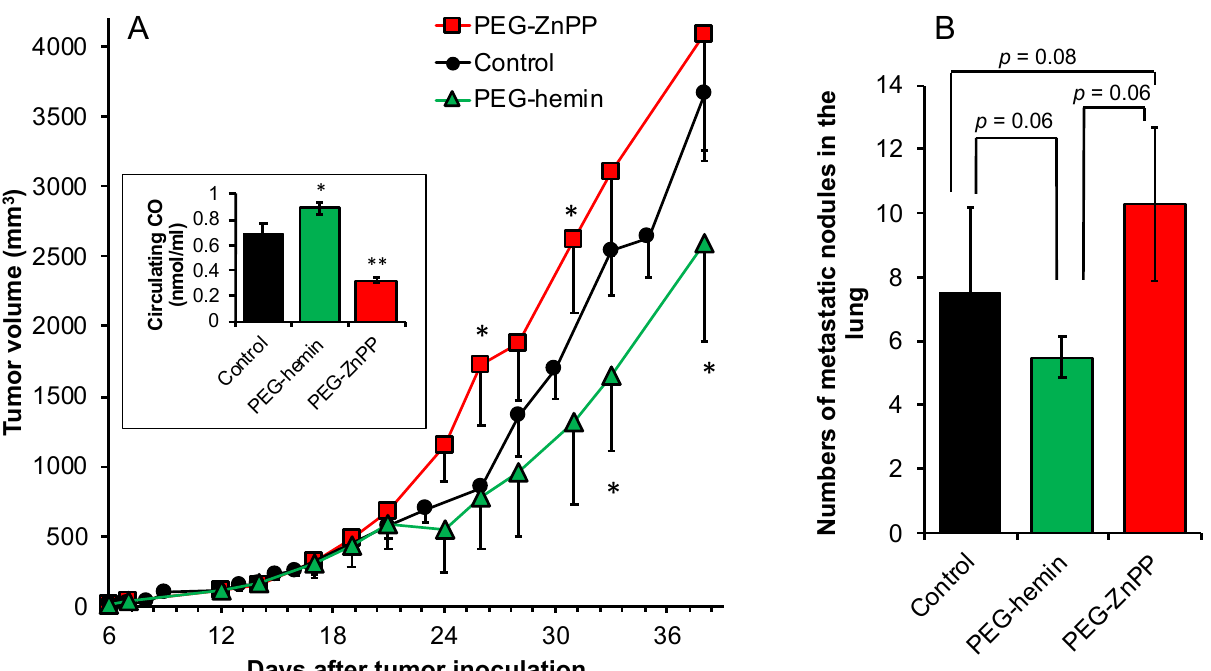
Figure 6. Effect of HO-1 inducer (PEG-hemin) and HO-1 inhibitor (PEG-ZnPP) on the growth of C26 solid tumor. Mouse colon cancer C26 solid tumor model using wild-type C26 cells was used in this study. One week before inoculation of C26 cells into mice, the mice were treated with PEG-hemin or PEG-ZnPP, both at 5 mg/kg (hemin or ZnPP equivalent) by intravenous injection (i.v.) thrice a week, which continued to 1 week after tumor inoculation. The tumor volumes were recorded every 2–3 days during the period of experiment ( A ). At 40 days after tumor inoculation, mice were killed, and the lungs were collected. Tumor nodules in the lung were identified macroscopically, and numbers of metastatic nodules and each diameter were counted ( B ). Data are mean ± SEM, n = 6–8. * p < 0.05; ** p < 0.01. See text for details.